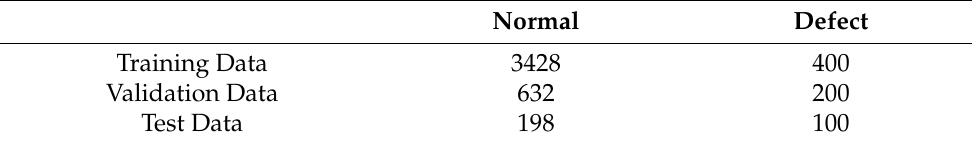
Table 6. Dataset of Case